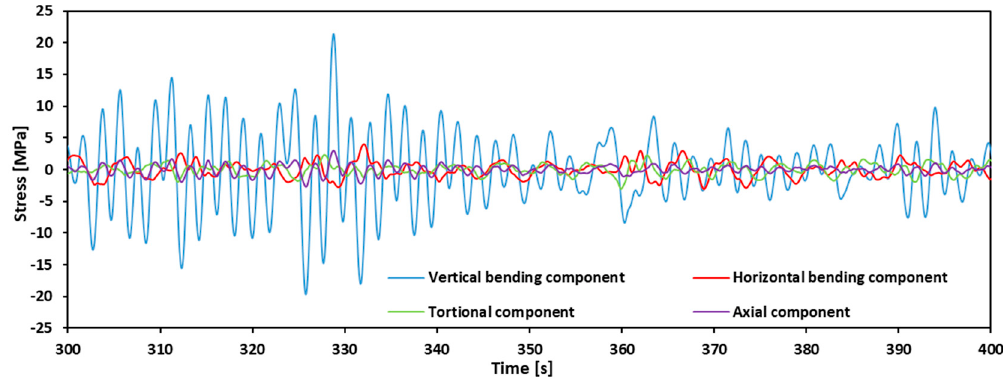
Figure 3. Time-series stress data of raw data after separation of the four components.